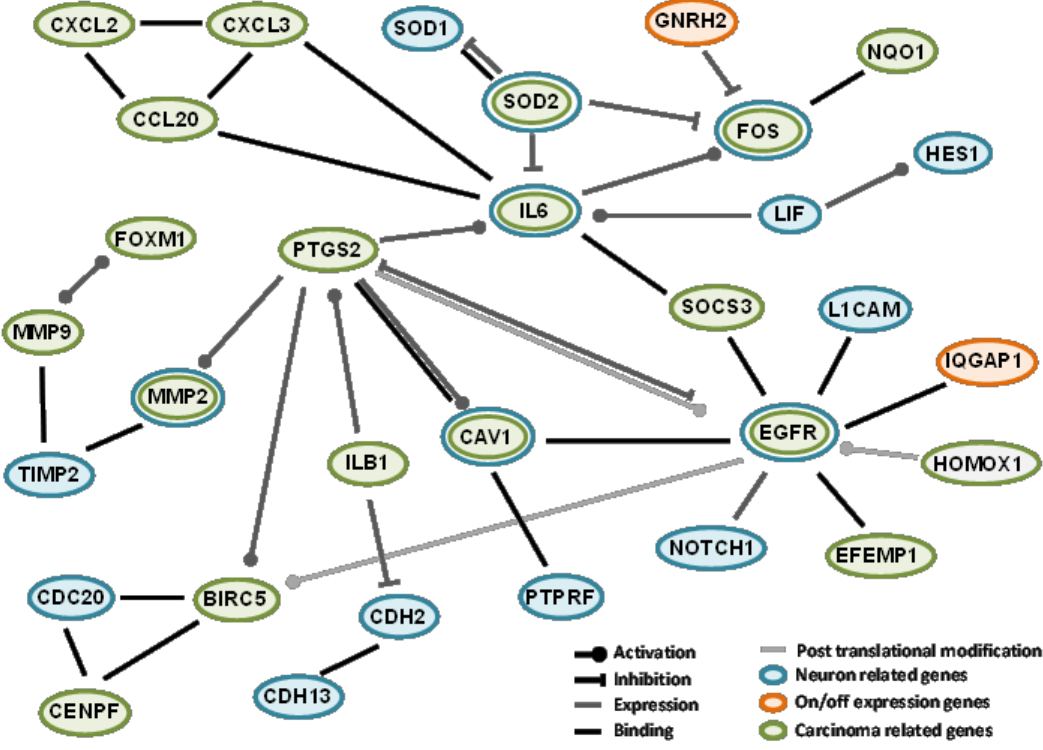
Figure 2. Protein interaction and association network among some of the genes identified in the differential transcriptomics. Orange ovals represent genes with ―on-off‖ differential expression, green oval genes relate with breast neoplasms and carcinoma hepatocellular and blue oval genes relate to neurogenesis, neuron differentiation, and neuron